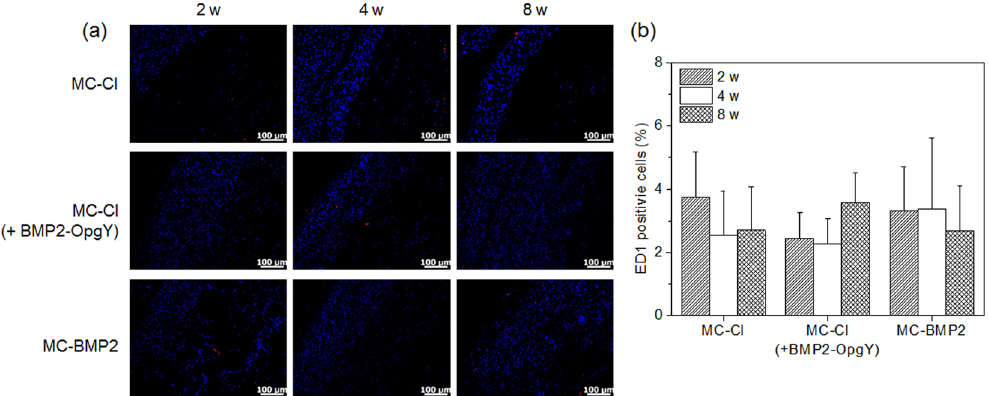
Figure 7. ( a ) Immunofluorescent staining of ED-1 (red) and DAPI (blue) (magnification 200 × , scale bars represent 100 μ m) ( b ) percentage quantification of the ED-1-positive cells (stained with DAPI) relative to the total number of cells in the section slides removed from nude mice receiving MC-Cl, MC-CL ( + BMP2-OpgY), or MC-BMP2 after 2, 4, or 8